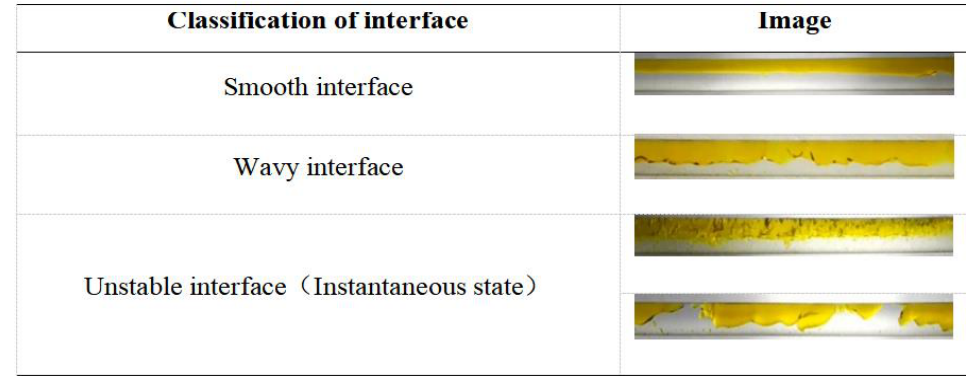
Figure 3. Three types of interface classification